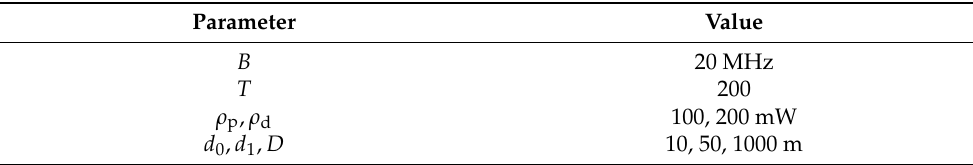
Table 2. Simulation Parameters.